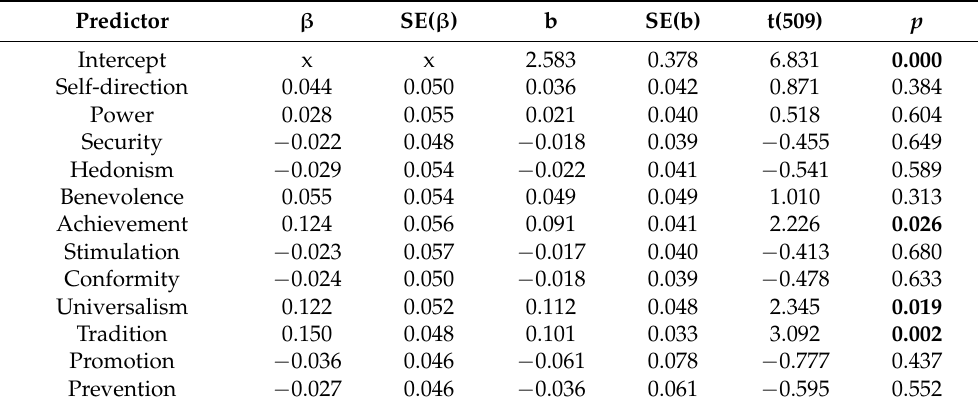
Table 10. The impact of the Schwartz values and regulatory focus on the WTP a price premium for domestic food products among women without control variables.